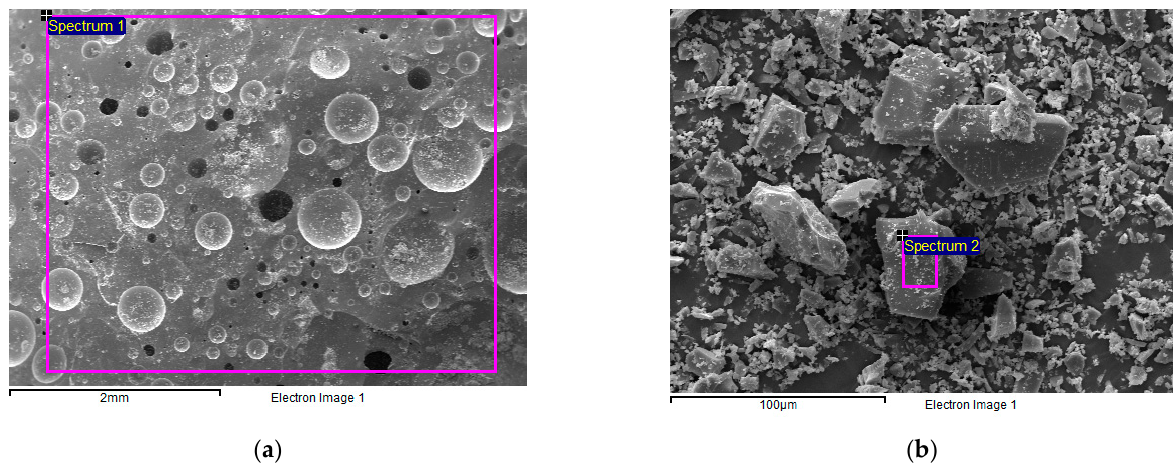
Figure 5. Infrared spectrum of cupola slag.